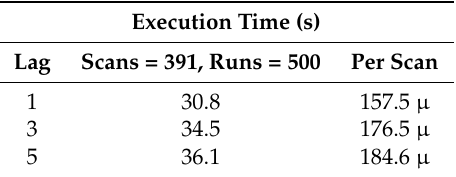
Table 3. Execution time of the B l 1 algorithm in an NN filter framework for different